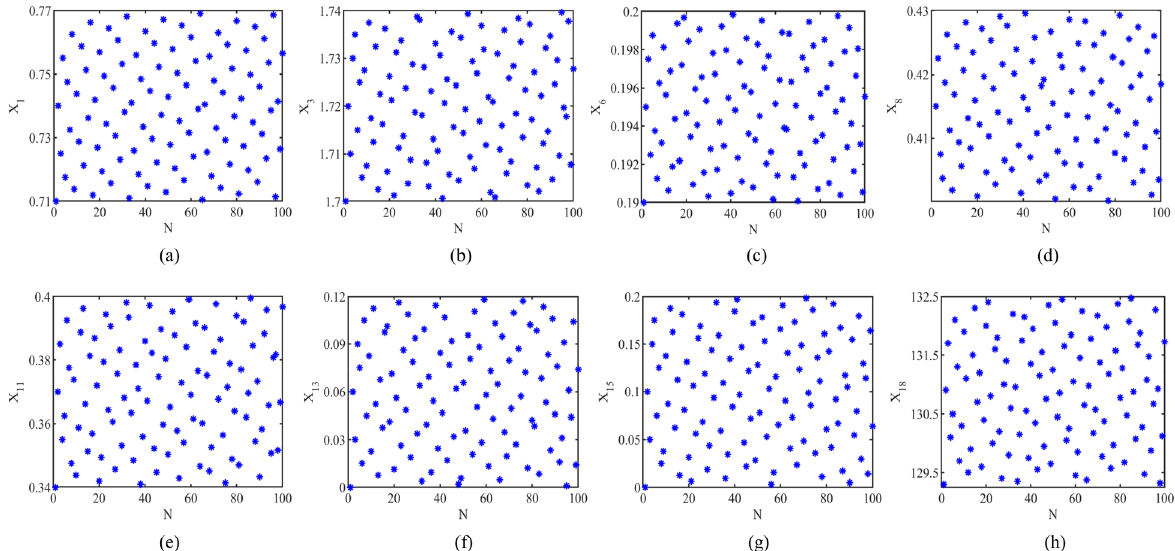
Figure 11. Sampling by the Sobol sequence.